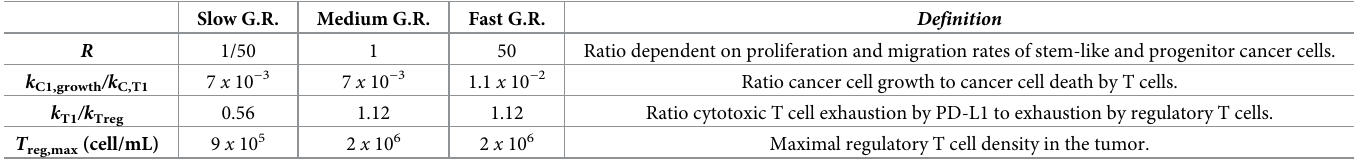
Table 4. Combinations of ratios k C1,growth /k C,T1 , k T1 /k Treg , and the parameter T reg,max , where k C1,growth , k C,T1 , k T1 , k Treg , and T reg,max are the cancer cell growth rate, the rate of cancer cell death by T cells, the exhaustion rate of cytotoxic T cells by all cells that express PD-L1, the inhibition rate of cytotoxic T cells by regulatory T cells, and the maximal regulatory T cell density in the tumor, respectively. G.R. stands for growth rate. Slow